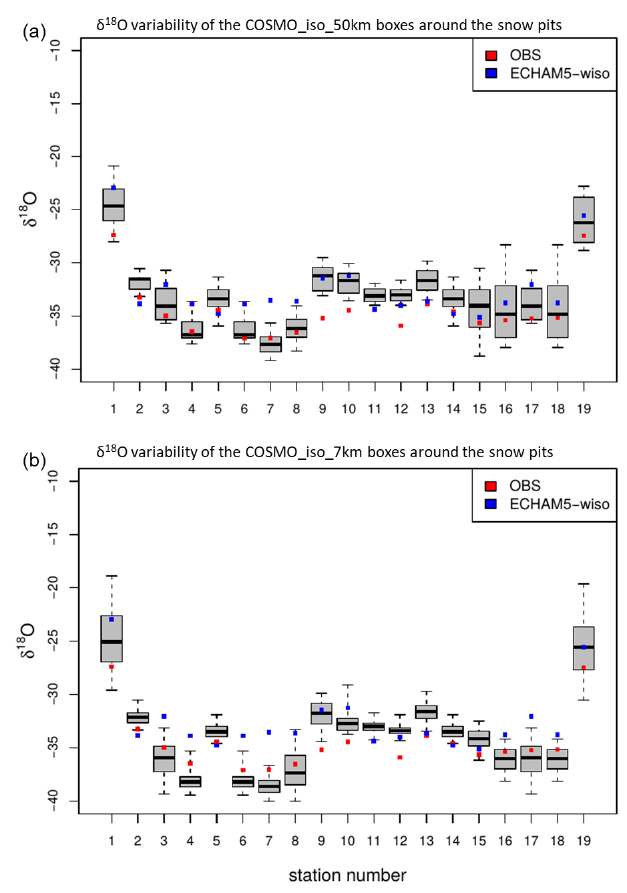
Figure 6. Present-day isotopic ratio variability of the COSMO_iso grid boxes surrounding the 16 snow pit samples for the (a) 50km and (b) 7km simulation. The black bar in the box and whisker plot represents the median of the isotope ratio distribution. The box comprises the upper and lower quartile, and the whiskers show the whole distribution. The MPI-ESM-wiso results are shown by the blue dots, and the observed δ 18 O values are shown by the red